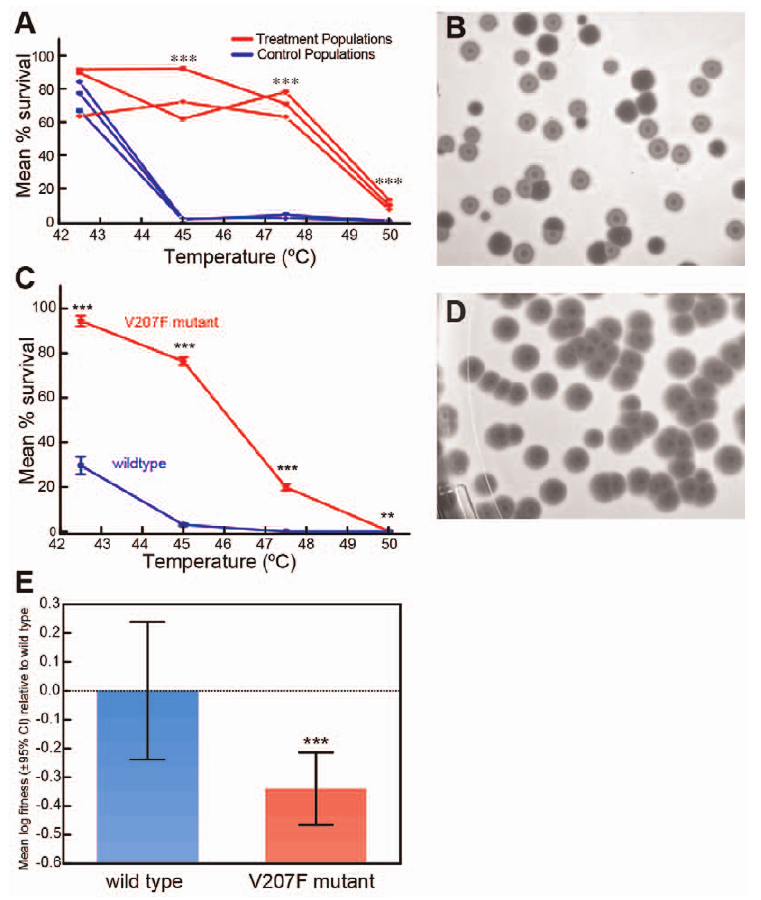
Figure 1. Evolution of W 6 under thermal pressure. A) Survival of evolved virus lineages as a function of heat shock temperature after a thermal selection with 20 50 u C-heat shocks every five generations, or identical passage without heat shock. B) Viruses evolved under heat shock showed a ‘bull’s eye’ phenotype in which plaques appeared partially turbid due to residual bacterial growth within the plaque (closed arrows). Normal plaques from wildtype viruses mixed into the sample are labeled with open arrows. C) Survival of a virus genotype with mutation V207F only is greater than the wildtype virus at elevated temperatures. Each point is the mean percent survival ( 6 std. err.) of 3 to 5 survival assays conducted for the strain, and error bars too small to be visualized are omitted for clarity. *** indicates statistical significance at P , 0.0001, and ** is statistical significance at P =0.004. These results qualitatively agree with those in panel (A) comparing evolved treatment and control populations, with a significant statistical advantage apparent for the V207F mutant at all temperatures tested. D) Bull’s eye phenotype of a virus genotype with mutation V207F only. E) The V207F mutation in P5 causes a fitness disadvantage at 25 u C relative to wildtype virus; bars indicate means ( 6 95% C.I.). *** indicates statistical significance at P <